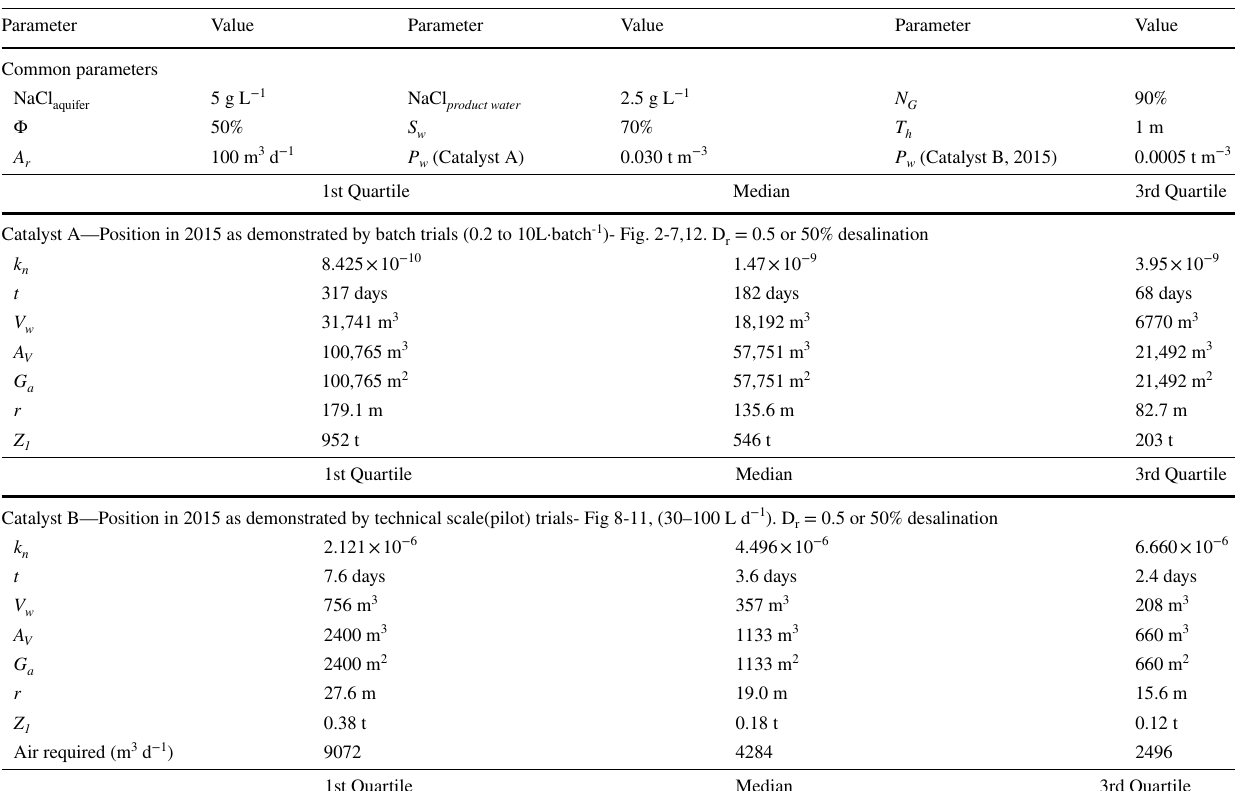
Table 1 Example saline aquifer parameters